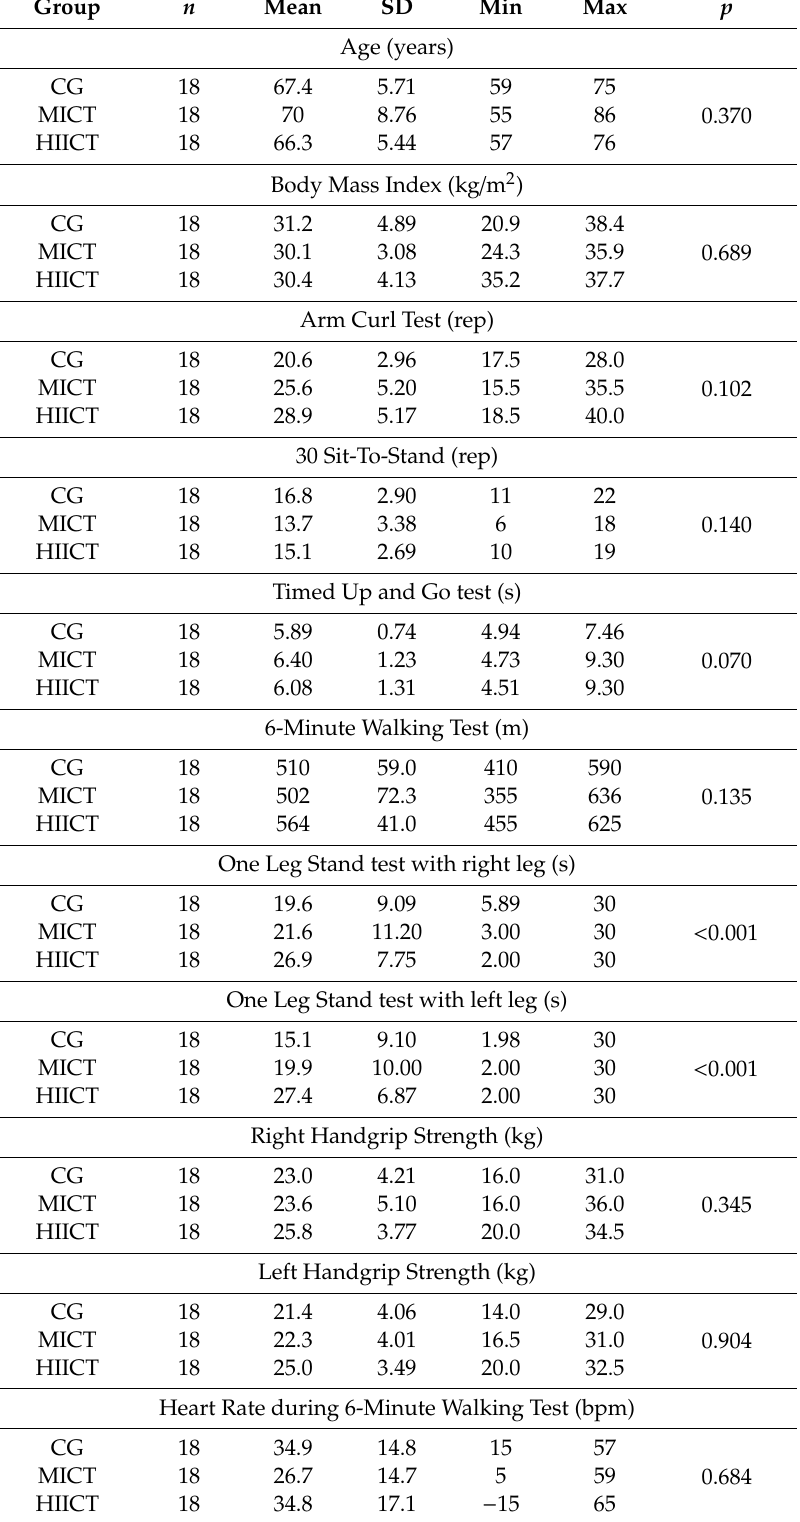
Table 3. Characteristics at baseline ( n =